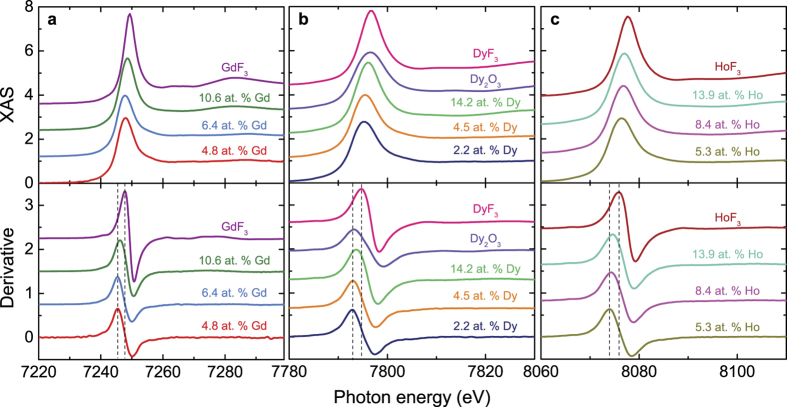
XANES spectra (top panels) and their first derivatives (bottom panels) at the RE L3 edge of (a) Gd; (b) Dy; and (c) Ho in RE-doped Bi2(Se, Te)3 thin films. For comparison the following reference standards are shown: (a) GdF3; (b) Dy2O3 and DyF3; and (c) HoF3. Both spectra and derivatives have been vertically shifted for clarity. Dotted lines mark the position of the maxima in the derivatives for the lowest RE concentration and the associated (RE)F3 standard.